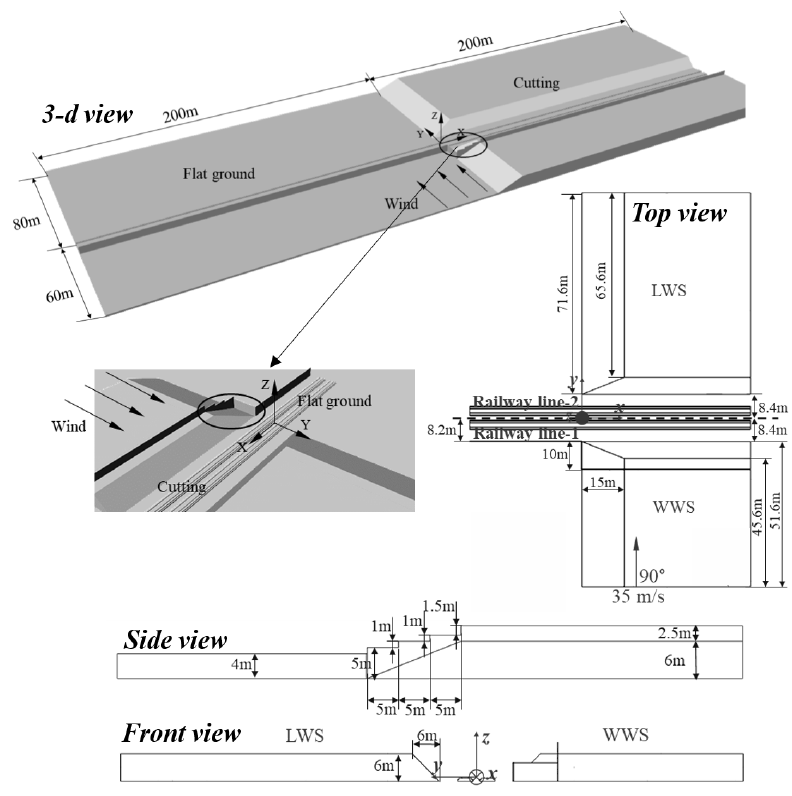
Figure 2. WT region in the study simulation.